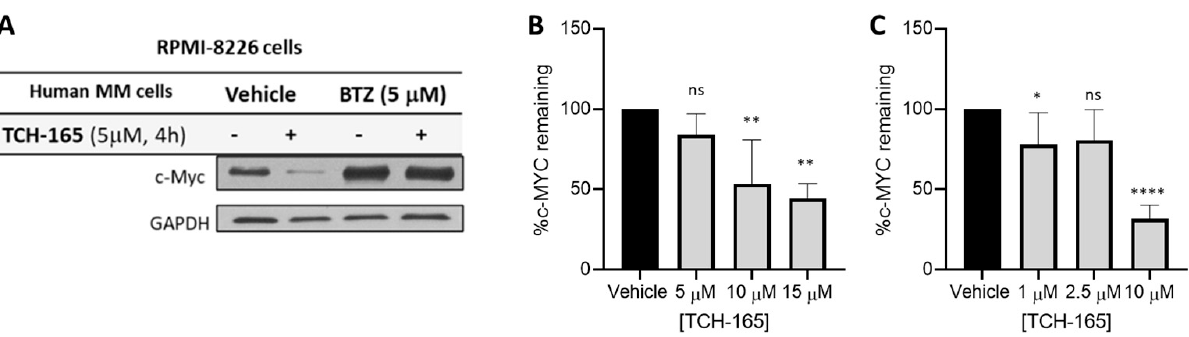
Figure 2. ( A ) Multiple Myeloma (RPMI-8226) cells treated with vehicle or TCH-165 (4 h, 5 mM) in the presence and absence of proteasome inhibitor BTZ (5 µ M); ( B ) percent MYC remaining in L363 cells treated with various concentrations of TCH-165 (n = 3); ( C ) percent MYC remaining in H929 cells treated with various concentrations of TCH-165 (n = 4). * p < 0.05, ** p < 0.01, *** p < 0.001, **** p